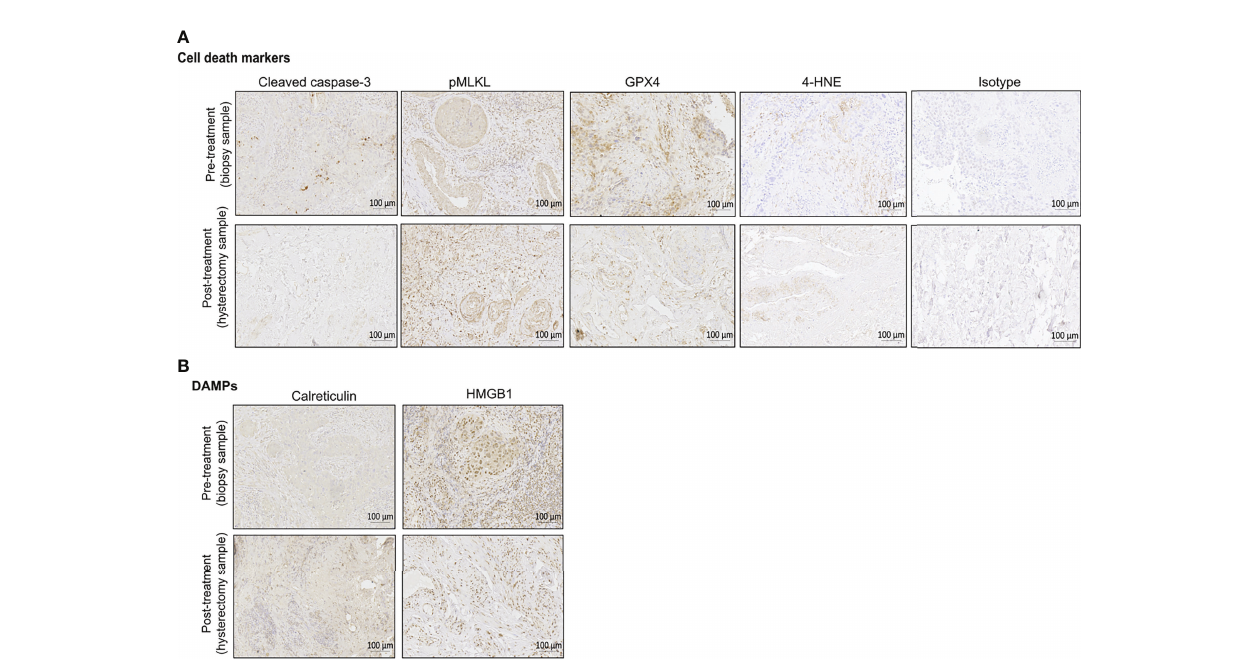
FIGURE 2 | Representative immunohistochemical (IHC) staining of pre-treatment biopsy and post-treatment hysterectomy samples for the different cell death markers (A) and DAMPs (B) . Bright fi eld images were taken with ZEISS Axio Scan.Z1 at a magni fi cation of 20x. Scales bars are 100 µm as indicated on the images. One example of isotype control is also shown in this fi gure. For the pre-treatment biopsy, the percentages of positive cells per tissue slice are the following: cleaved caspase-3 (6,77%), pMLKL (53,12%), GPX4 (53,9%), 4-HNE (0,73%), calreticulin (7,24%), HMGB1 (66,37%). For the post-treatment hysterectomy, the percentages of positive cells per tissue slice are the following: cleaved caspase-3 (1,66%), pMLKL (31,42%), GPX4 (15,5%), 4-HNE (0,86%), calreticulin (52,10%), HMGB1 (34,53%).